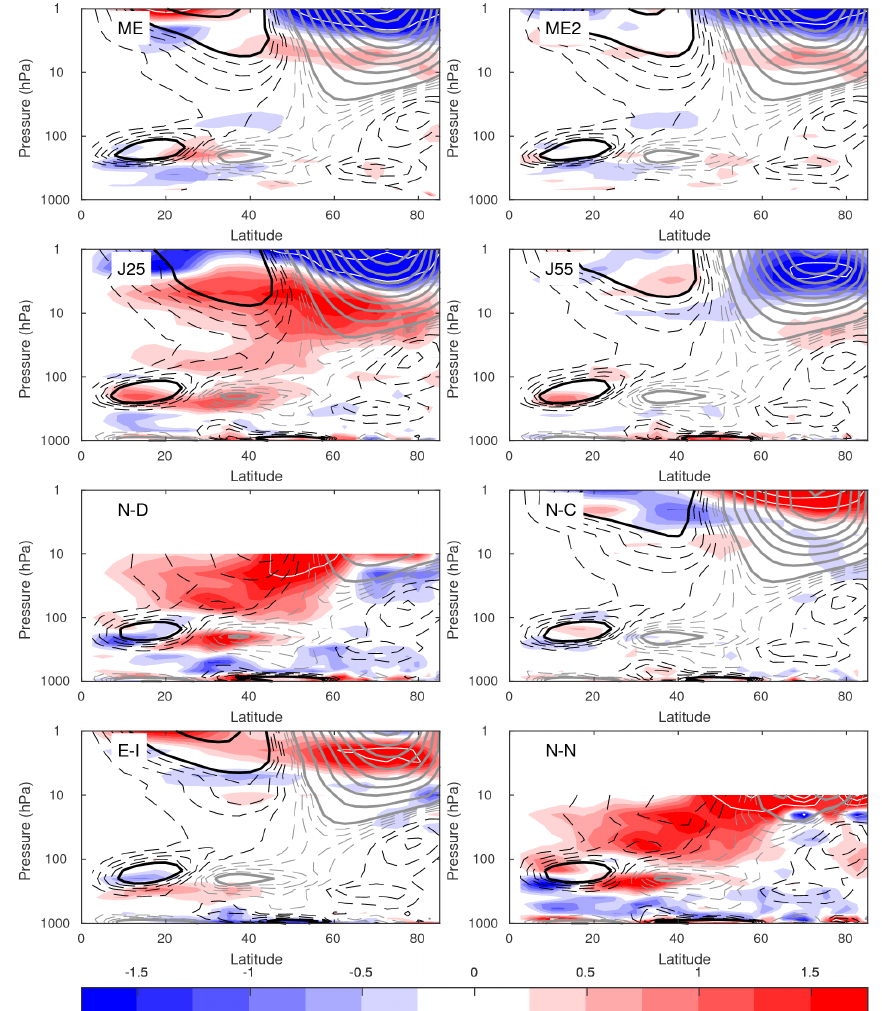
Figure 8. Latitude–pressure cross section of the Coriolis torque averaged from lag − 5 to 0 days during SSW events for different reanalysis datasets. The positive and negative values are contoured in black and grey, respectively. Dashed contours range from − 4 to 4ms − 1 day − 1 in steps of 1ms − 1 day − 1 and solid contours are used from 5ms − 1 day − 1 and larger in steps of 5ms − 1 day − 1 . Biases with respect to the mean of LRE members are illustrated with red and blue shading for positive and negative values, respectively. The color interval is 0.25ms − 1 day − 1 from − 1.75 to 1.75. Values larger (smaller) than 2 ( − 2) are contoured every 2ms − 1 day − 1 in